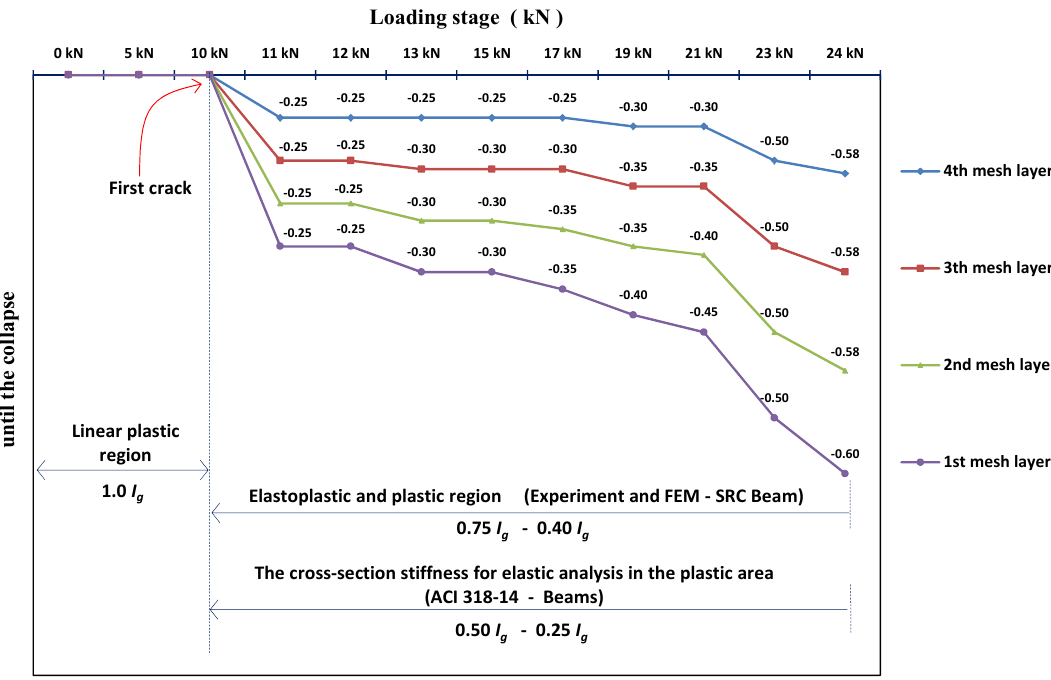
Figure 21. Decreased stiffness of BRC beam cross-section in the span middle.